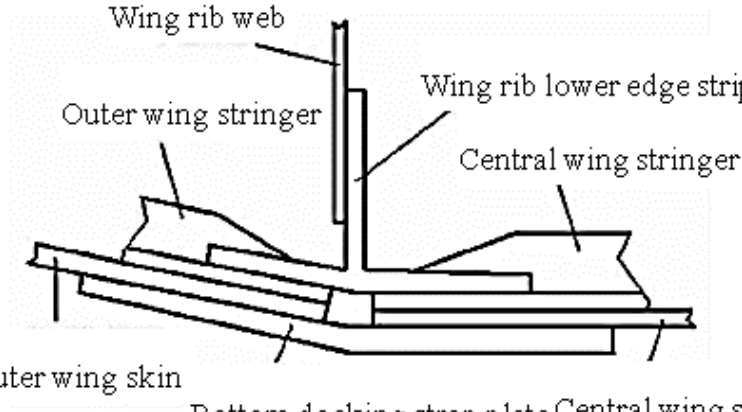
Figure 1. Schematic diagram of the docking of the lower panel of a typical metal wing. Strap plate connection is also used in the structure of aircraft skin connection. The structure of the fuselage skin connection is related to factors such as the number of fasteners, the location of the long stringers, and the use of strap plates. Figure 2 lists two structural forms of the fuselage longitudinal skin connection. The structure of Figure 2a is a single-strip plate lap joint, and the structure of Figure 2b is a double-strip plate lap joint.